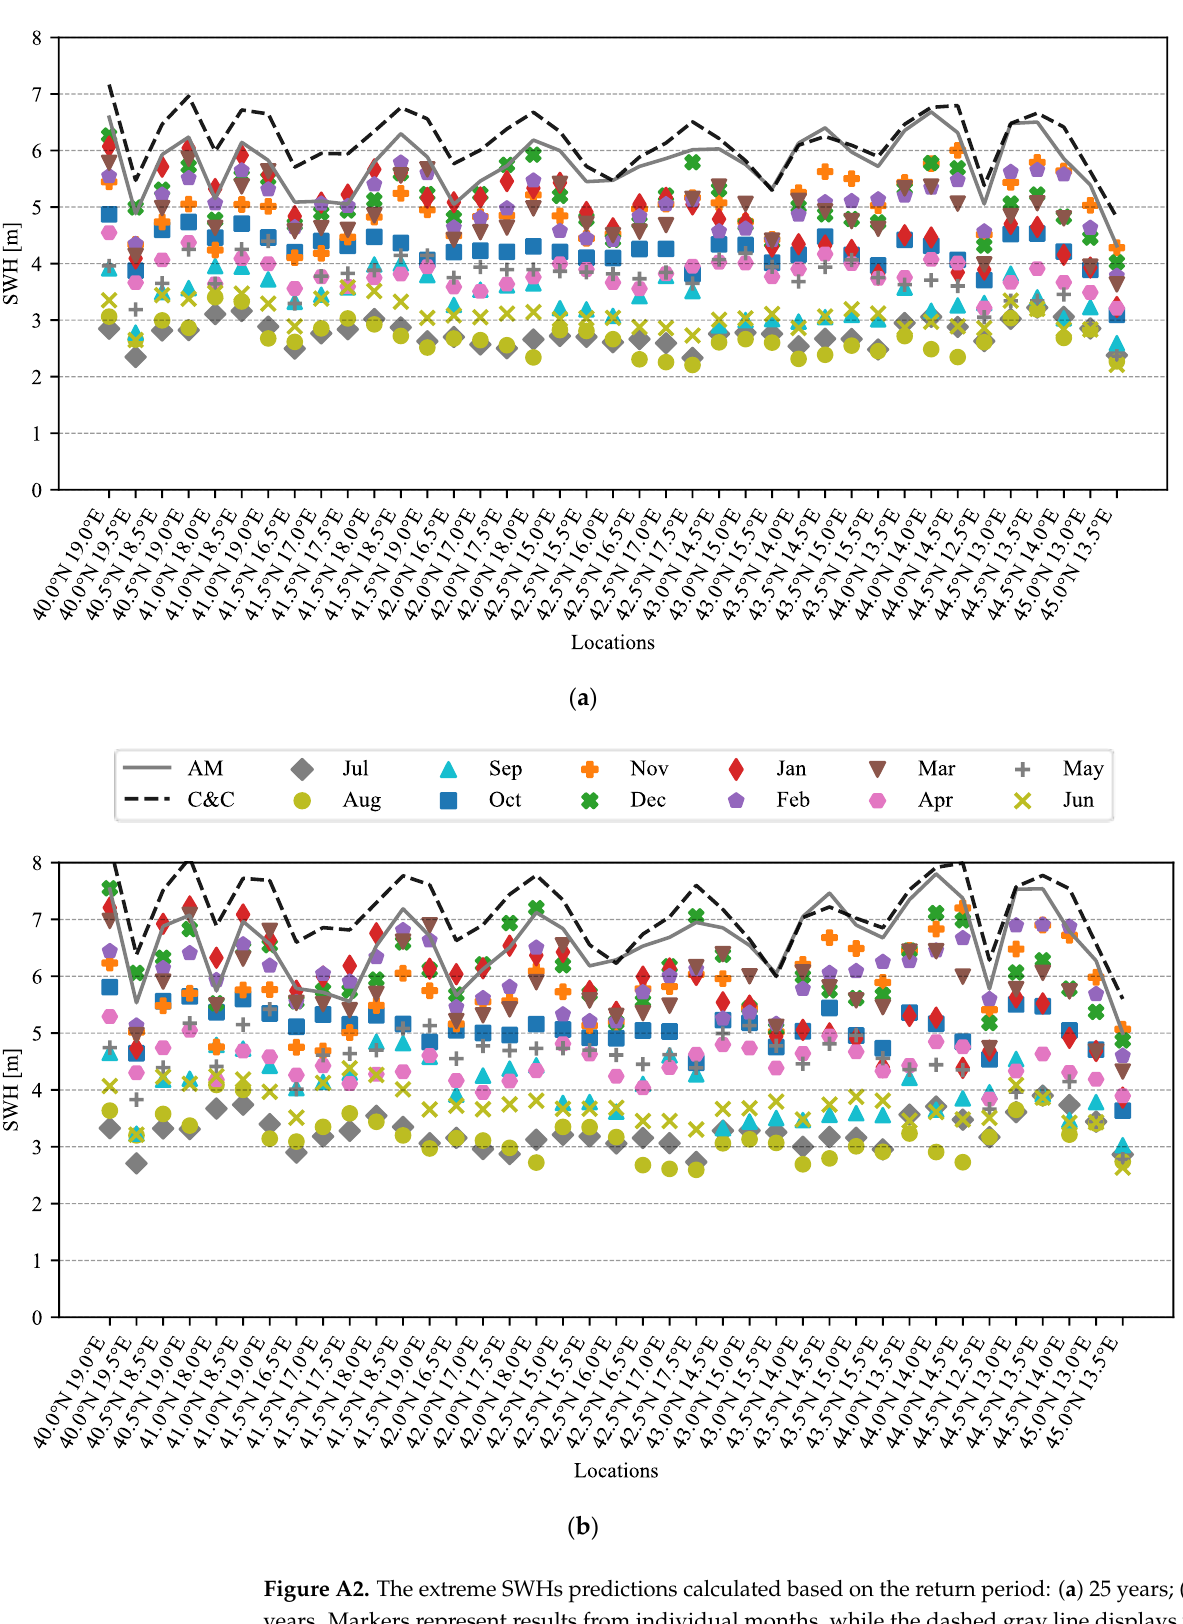
Figure A2. The extreme SWHs predictions calculated based on the return period: ( a ) 25 years; ( b ) 100 years. Markers represent results from individual months, while the dashed gray line displays values obtained by the C–C approach combining MM.